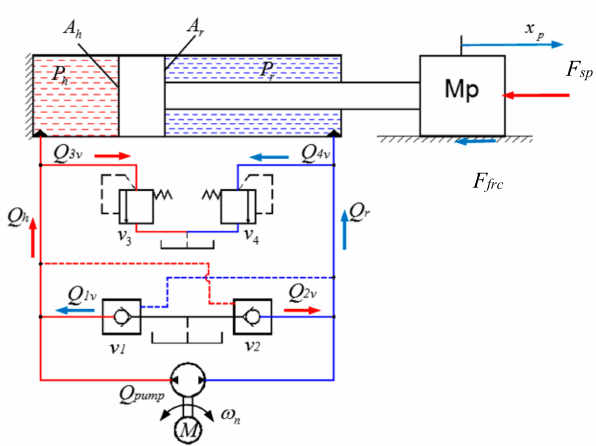
Figure 1. Schematic of an electro-hydraulic actuator (EHA)